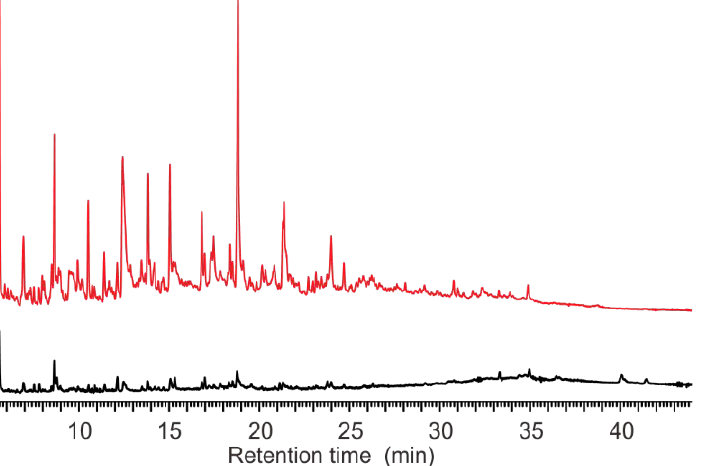
Figure 7. Pyrograms of A. calcoaceticus (black line) and S. aureus (red line) at 800